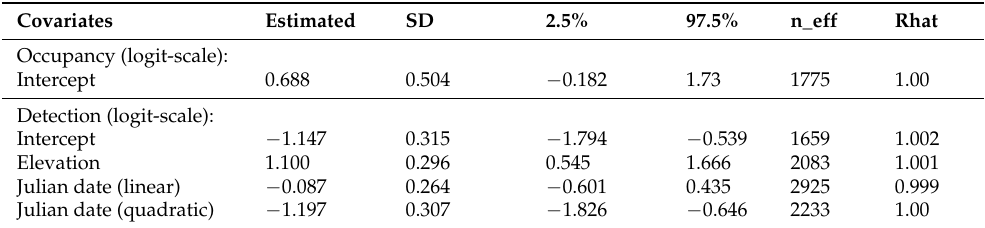
Table A11. Output summary from the best occupancy model ( ψ (intercept); ρ (intercept + Julian day + Julian day 2 )) of wild goat ( Capra hircus ) in Puerto Rico. Runtime: 49.586 s.